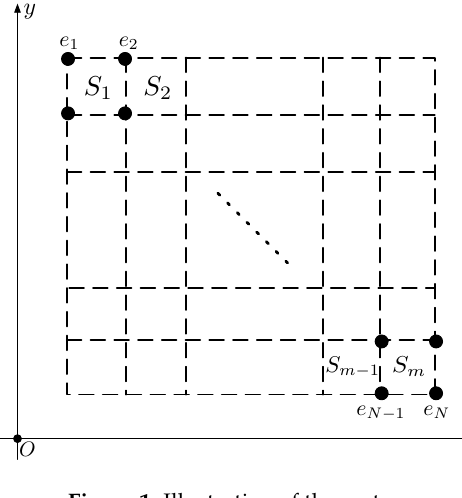
Figure 1. Illustration of the system.